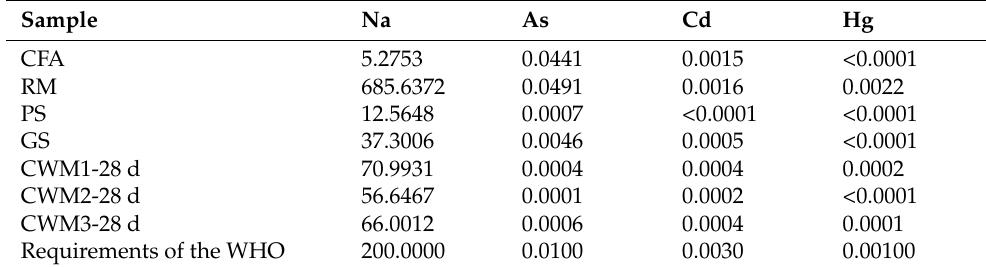
Table 5. Leaching results of harmful elements (mg/L).